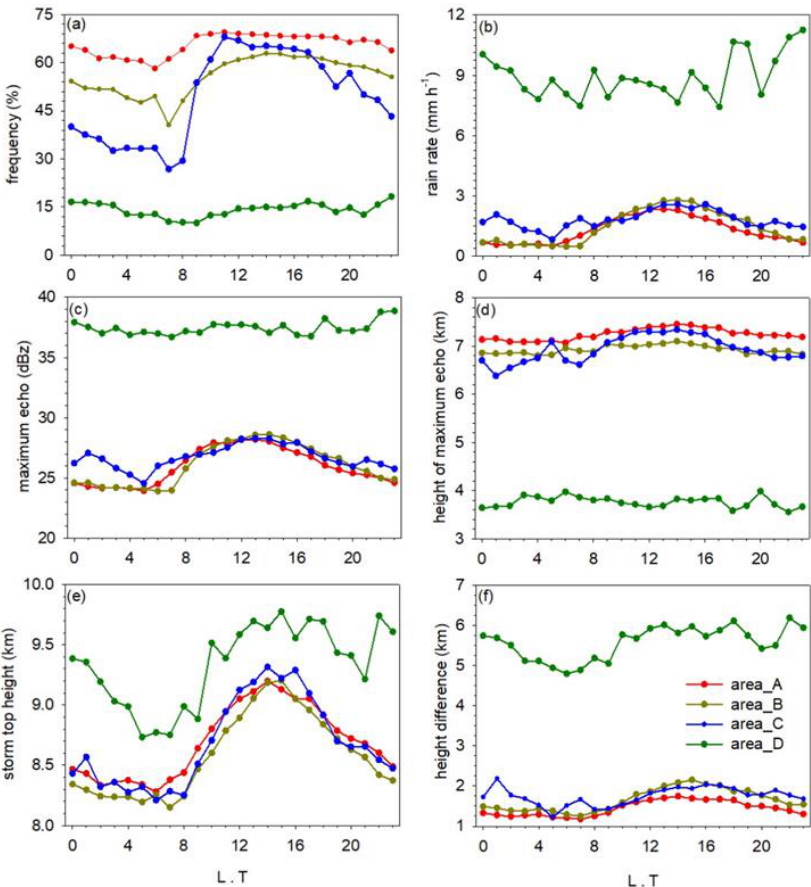
Figure 7. Diurnal variation curves of ( a ) precipitation frequency, ( b ) rain rate, ( c ) the maximum echo, ( d ) the altitude of maximum echo, ( e ) the storm top altitude, and ( f ) the height difference between the storm top and the altitude of the maximum echo for DCP in region A–D marked in Figure 1. The calculations were based on pixel data measured by TRMM PR in summer from 1998 to 2012.